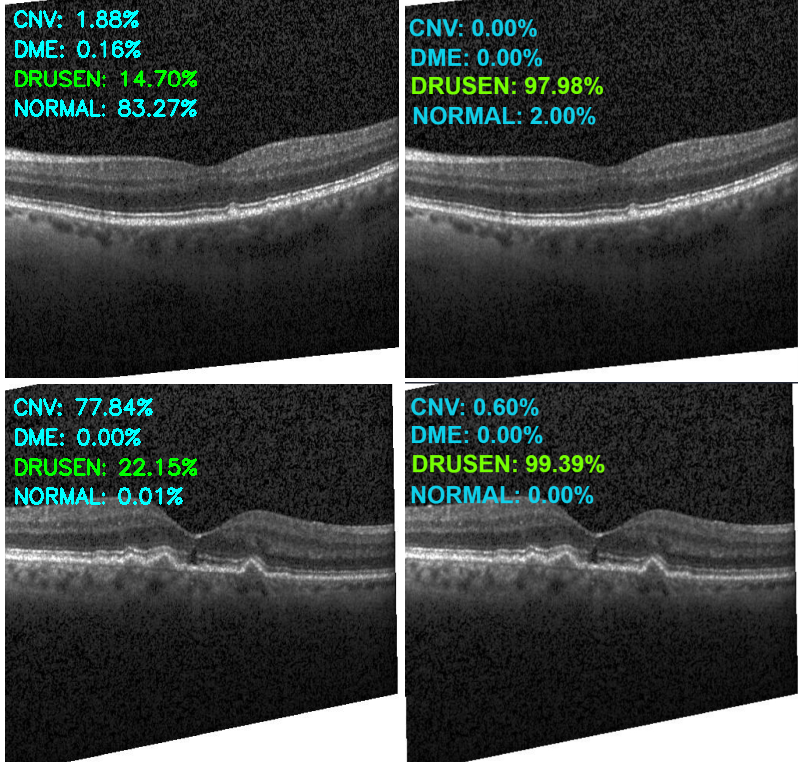
Figure 15. Exemplary result of proposed model trained without (left column) and with (right column) augmentation (correct label highlighted in